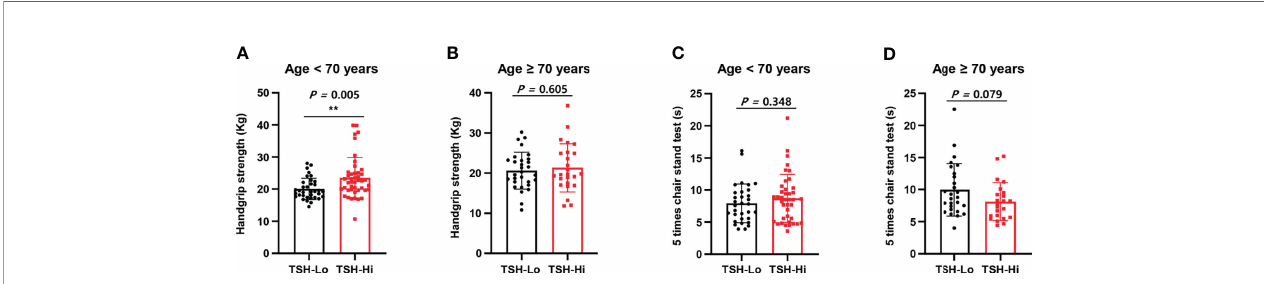
FIGURE 2 | Relationships of grip strength and chair-stand test results with serum TSH concentration and age. (A) Participants were allocated to two groups on the basis of age: <70 years and >70 years. Grip strength in the under-70s was signi fi cantly lower in the low-TSH group (TSH-Lo, <0.40 m U/mL). (B) Grip strength in the over-70s was similar in the high- (TSH-Hi, 0.40 – 4.0 m U/mL) and low-TSH groups. (C) The chair-stand test results were similarly analyzed. Among the under-70s, there was no difference between the low- and high-TSH groups. (D) Among the over-70s, there was also no difference between the low- and high-TSH groups. ** in the fi gure indicates p-value